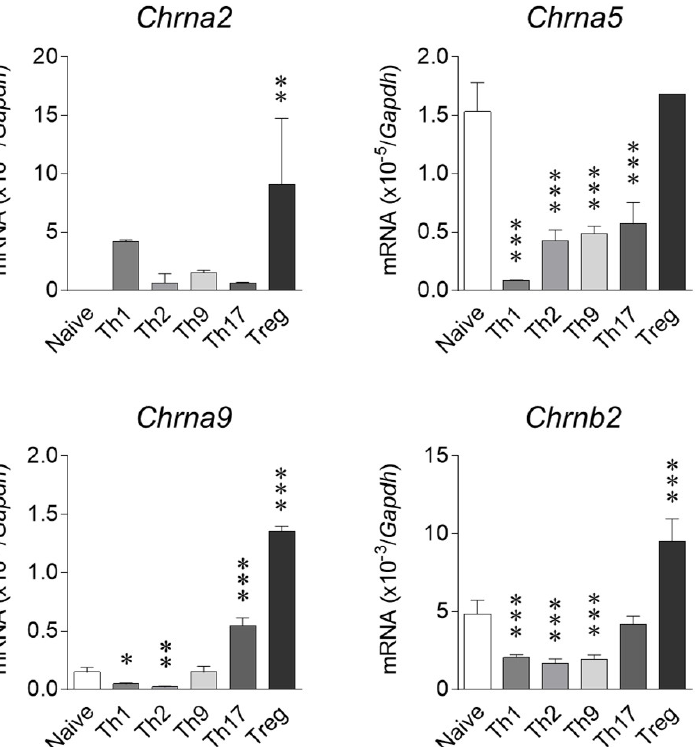
Figure 2. Expression of nAChRs in T-cell subsets. mRNA expression of nAChRs in T-cell subsets and naive CD4 + T cells were determined as described in Materials and Methods. Data are expressed as means ± SD of relative mRNA abundance normalized to Gapdh expression ( n = 2–4). * p < 0.05, ** p < 0.01, *** p < 0.001, relative to naive CD4 + T cells (Dunnett’s test).